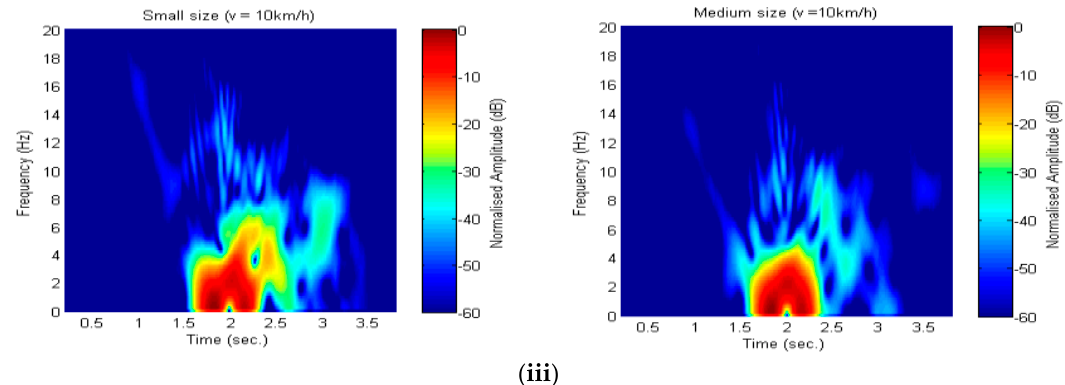
Figure 7. Received scattered signal in ( i ) time domain; ( ii ) power spectrum and ( iii ) spectrogram of moving vehicles crossing the Tx-Rx radar baseline for Compact and Saloon.